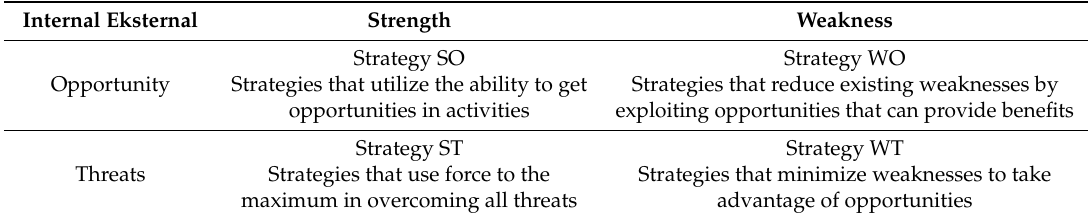
Table 2. Matrix of SWOT